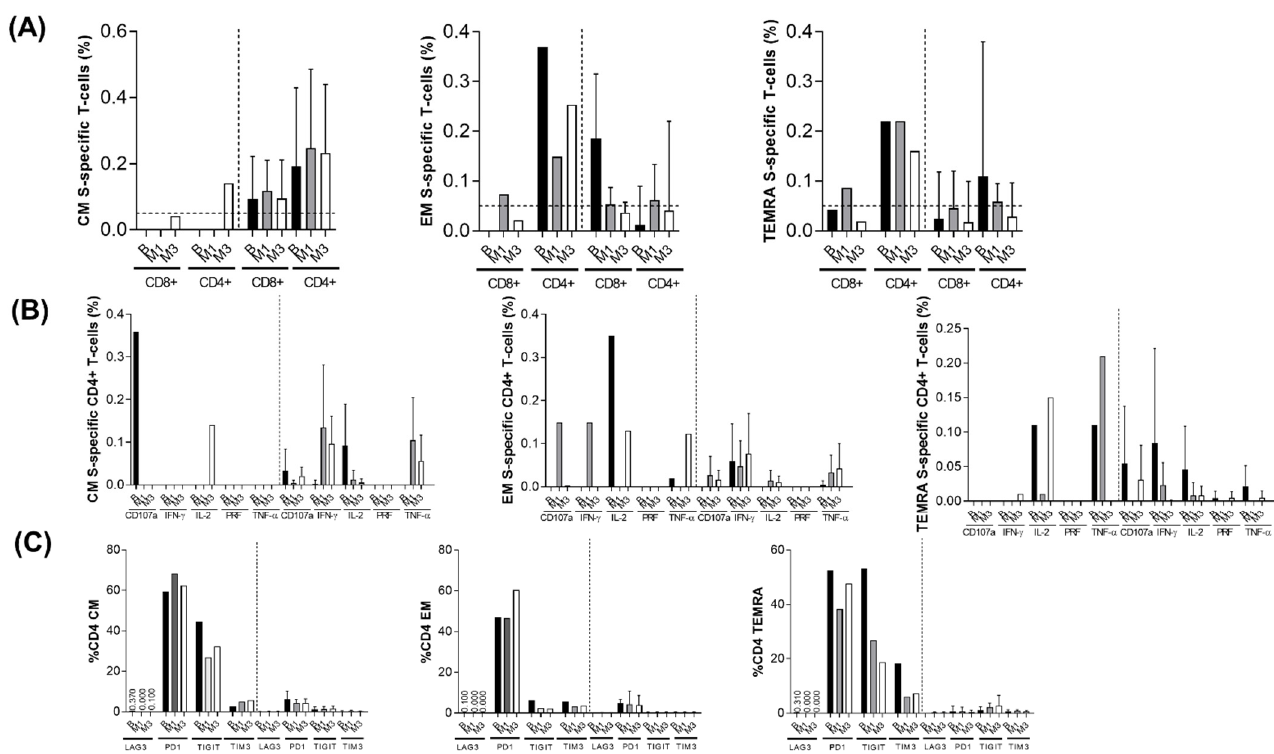
Figure 4. SARS-CoV-2 Spike-Specific T-Cell Response. ( A ) Spike-specific memory CD4+ T-cell subsets response, at baseline (B), month 1 (M1) and month 3 (M3), in our case (left panel) and controls (right panel): Central memory (CM), Effector memory (EM) and Subset of effector memory T-cells that expresses CD45RA (TEMRA). ( B ) Cytokines produced by memory CD4+ T-cell subsets (CM, EM, TEMRA), in response to SARS-CoV-2 S peptide, at baseline (B), month 1 (M1) and month 3 (M3) in our case (left panel) and controls (right panel): CD107a (degranulation marker), Interferon- γ (IFN- γ ), Interleukin 2 (IL-2), Perforin (PRF) and Tumour necrosis factor- α (TNF- α ). ( C ) Exhaustion markers from memory CD4+ T-cell subsets (CM, EM, TEMRA), at baseline (B), month 1 (M1) and month 3 (M3), in our case (left panel) and controls (right panel): Lymphocyte-activation gene 3 (LAG-3), Programmed cell death protein 1 (PD-1), T-cell immunoreceptor with Ig and ITIM (immunoreceptor tyrosine-based inhibitory).